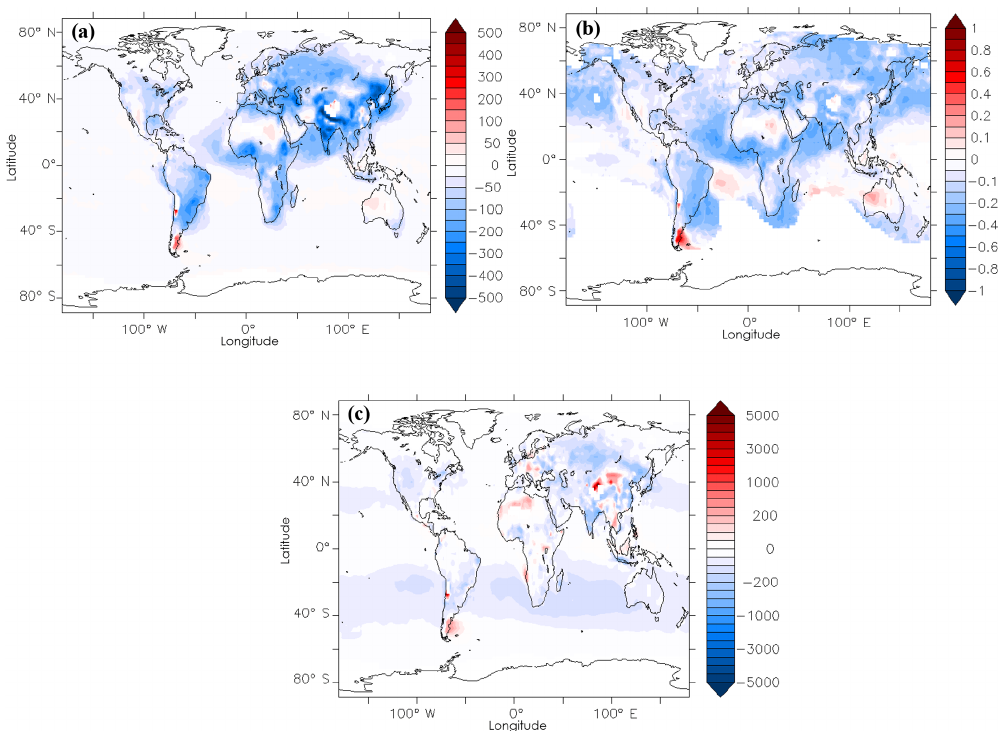
Figure 6. (a) Absolute (in cm − 3 ) and (b) fractional annual change in the predicted CDNC, and (c) absolute (in cm − 3 ) change in the predicted aerosol number concentration (at the lowest cloud-forming level, 940hPa) by switching on/off the mineral dust emissions. A positive change corresponds to an increase from the presence of